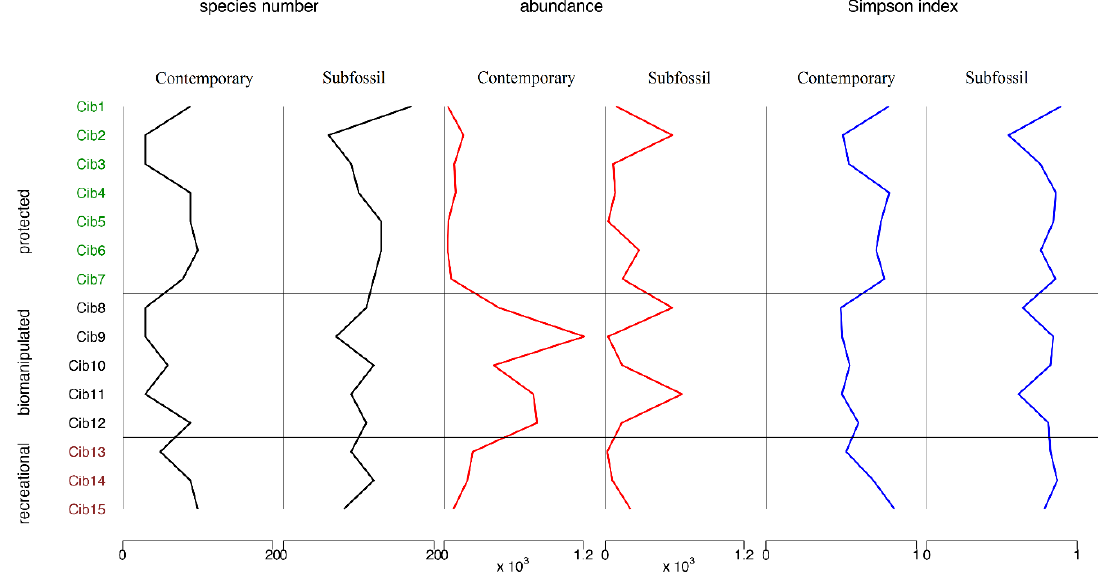
Figure 2. Number of species (ND), abundances (individual L − 1 / individual cm − 3 ), and Simpson diversity (ND) of contemporary and subfossil Cladocera communities (ND: no dimension).